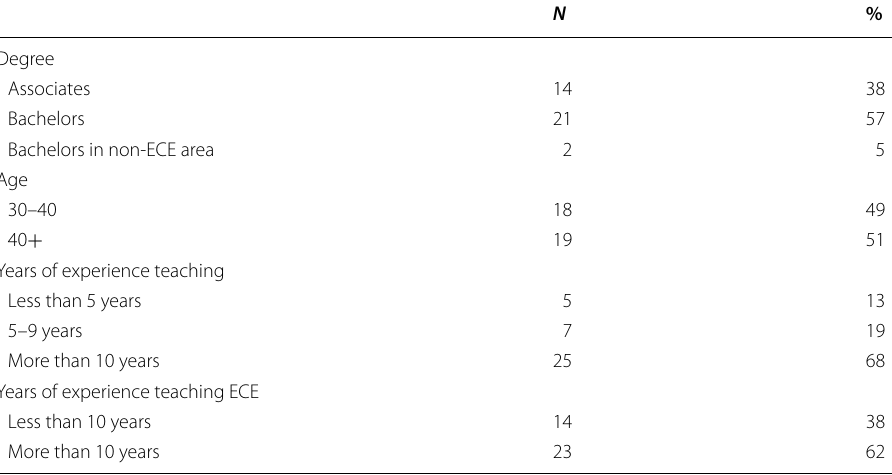
Table 1 Demographics for the 37 participants in the